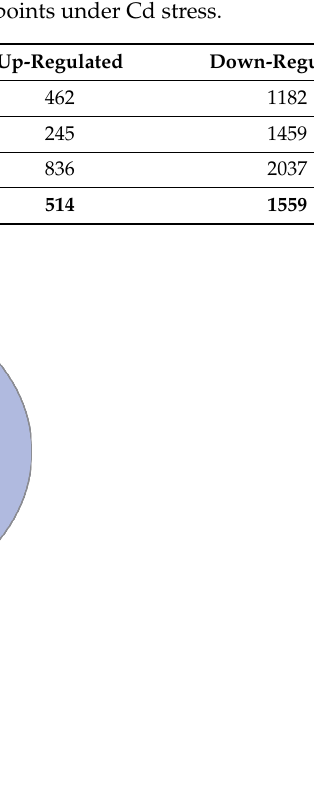
Figure 3. Venn diagram of differentially expressed genes from three comparative stages under Cd stress. Differential gene expression obtained by Venn diagram analysis. The number of differential gene expression profiles in the three libraries was obtained from the three comparative stages under Cd stress. The number of DEGs that overlap between G0 (7d), G5 (14d) and G8